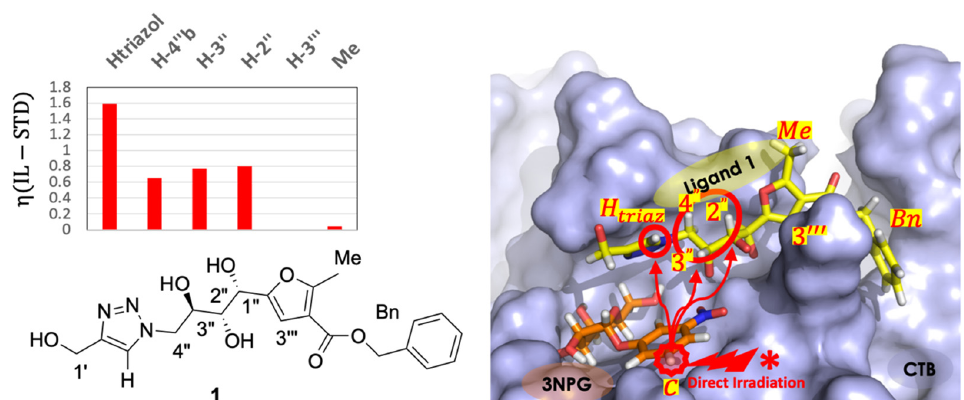
Figure 7. ( Left ): η ( IL − STD ) factors of protons of 1 , indicating spatial proximity of protons Htriaz, 3 ″ , 2 ″ and 4 ″ b with proton Hc of 3NPG bound in the adjacent galactose subsite. ( Right ): 3D molecular model of the 3NPG/CTB/ 1 ternary complex highlighting the H-H spatial correlations observed by IL-STD NMR.